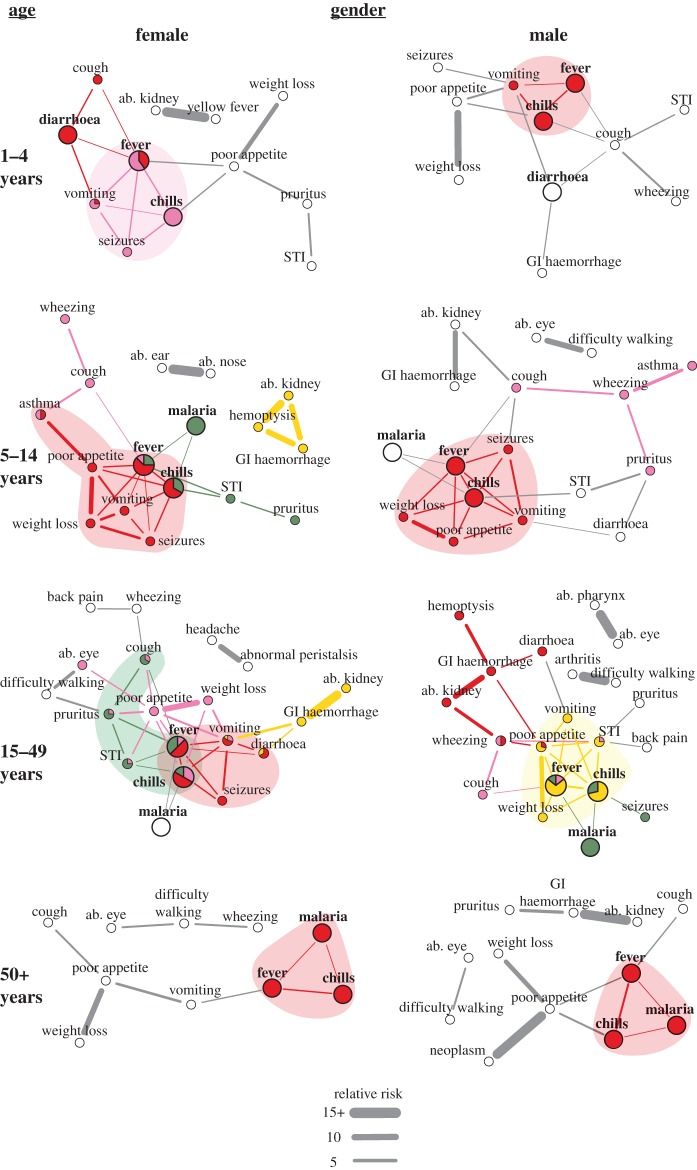
Comorbidity by age and gender. Nodes represent reported symptoms/diseases; HPO terms are shown for symptoms. ab. ‘abnormality of the’, GI ‘gastrointestinal’ and STI ‘sexually transmitted infection’. Edges shown had relative risk (RR) > 1, ϕ > 0 and q-value < 0.05. Widths of edges are capped at a RR of 15. Colours correspond to link clusters; grey edges and white nodes were not grouped into a link cluster. The main clusters for fever are shaded as a visual aid. A main cluster was where a majority of edges for fever were grouped. If there was no majority, all clusters with greater than 1 edge with fever were highlighted/shaded. Bolded and enlarged nodes were the symptoms/diseases that were most often co-reported with another symptom/disease. A force-directed layout for comorbidity networks was used; the most connected symptoms/diseases are shown in the centre of the graphs.